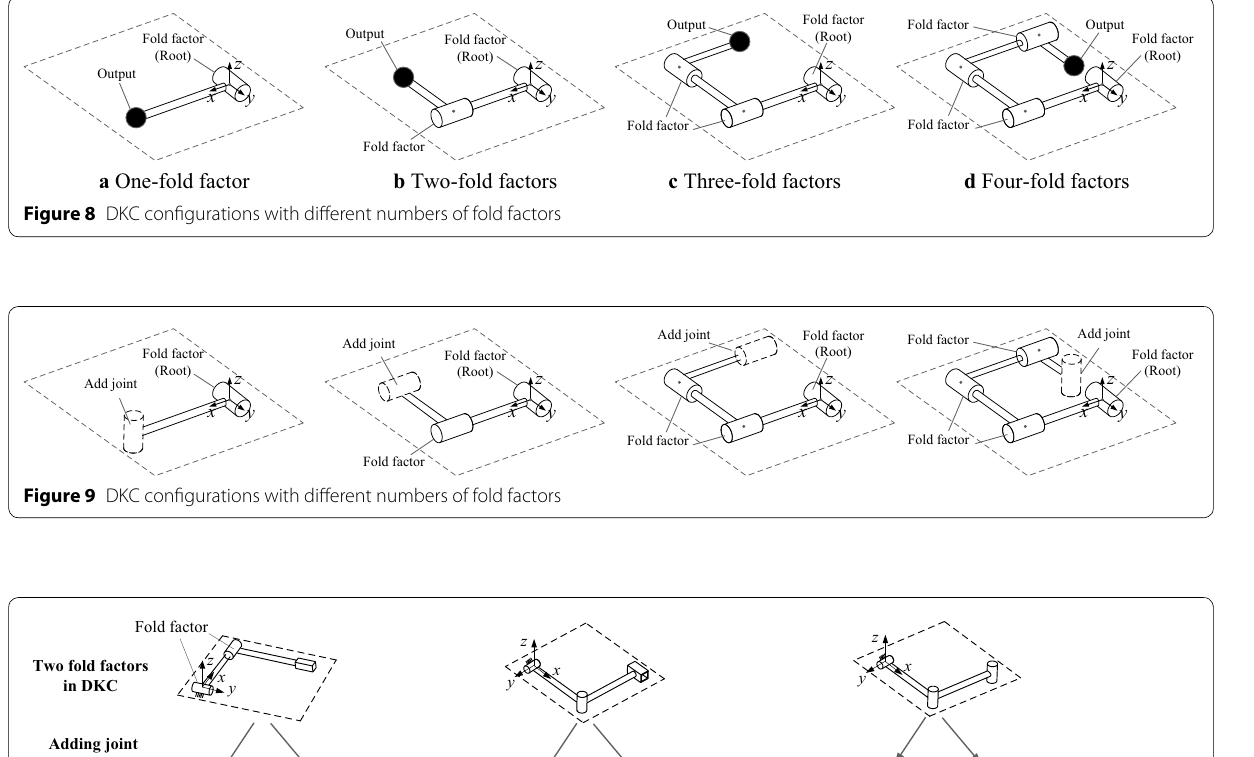
Two fold factors in DKC